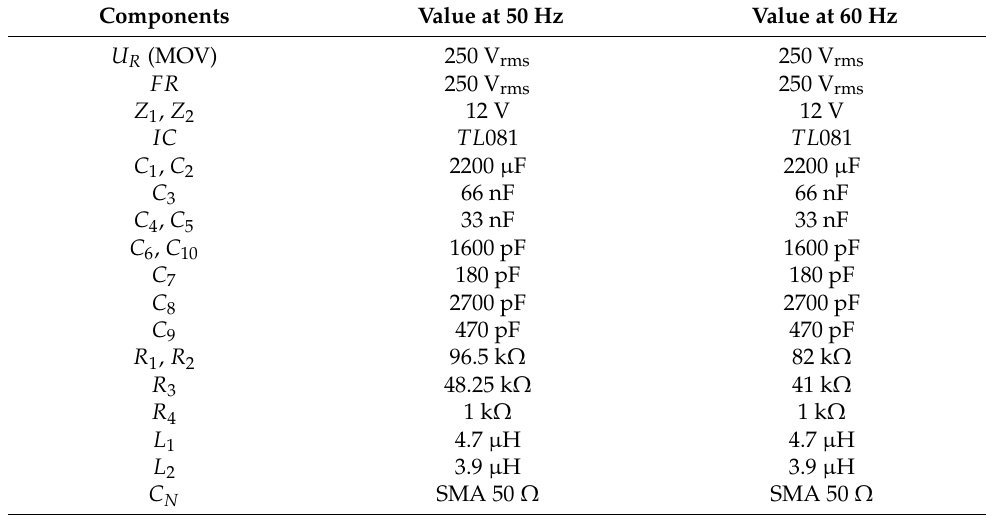
Table 2. The components of the NB–PLC notch coupling circuit prototype.